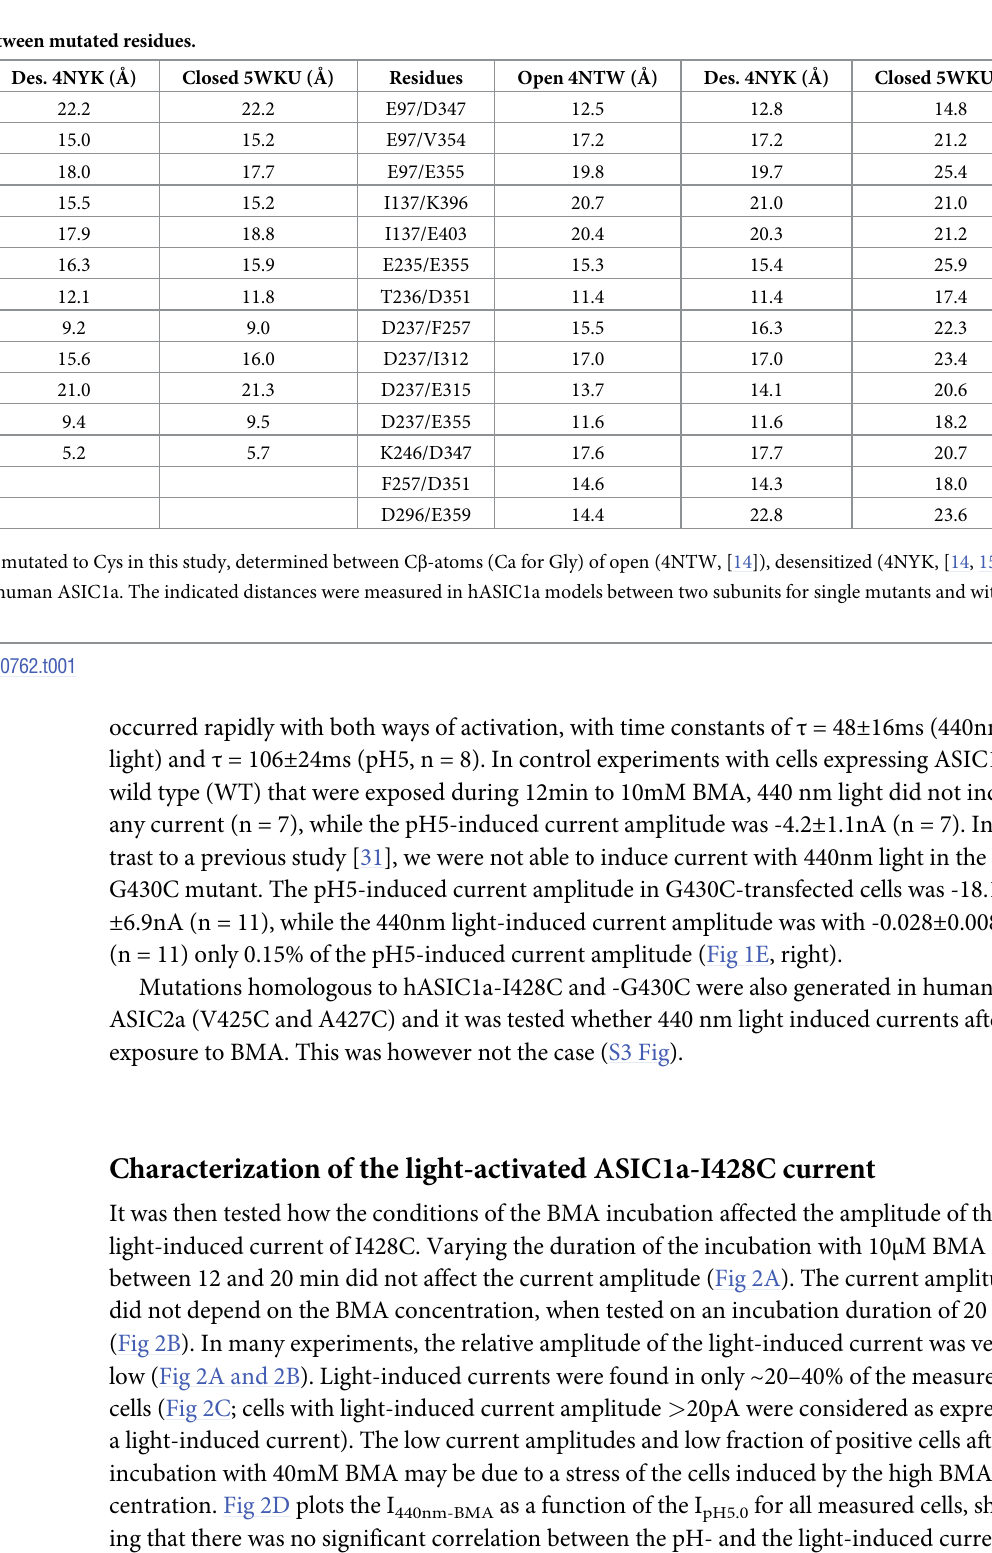
Table 1. Distance in ASIC1a WT between mutated residues. Residue Open 4NTW ( Å )